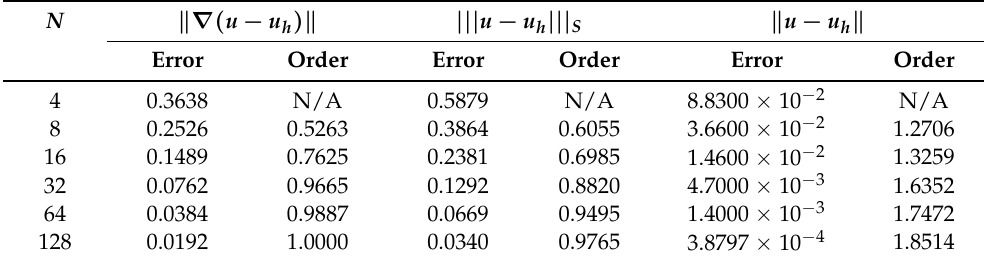
Table 9. Experiment results for the exact solution u = x 2 e y with B.C. V. N